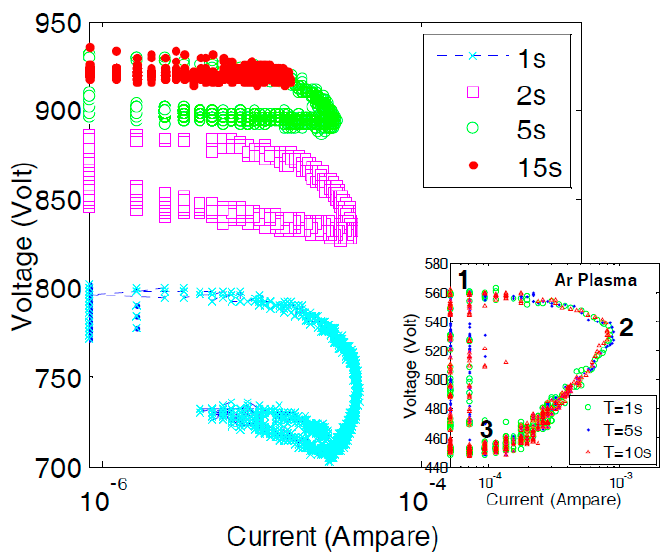
Figure 6. Plots of instantaneous current and voltage during self-pulsing discharge at different elapsed time, 1, 2, 5, and 15 s from ignition of C 2 H 2 plasma at the electrode gap distance of 150 μ m and the continuous source voltage of 1000 V. The inset is for Ar plasma jet at elapsed time 1, 2, and 5 s.